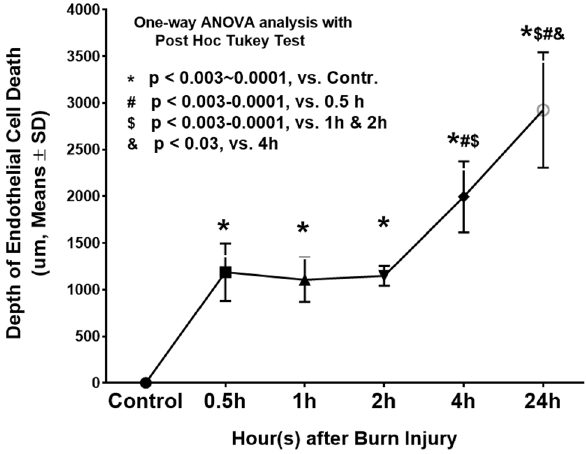
Figure 7. A diagram showing the vertical progression of endothelial cell death measured as the distance from the epidermis to the highest vertical location of positively vimentin-stained endothelial cells on the burn site of porcine skin biopsies harvested at various time points after